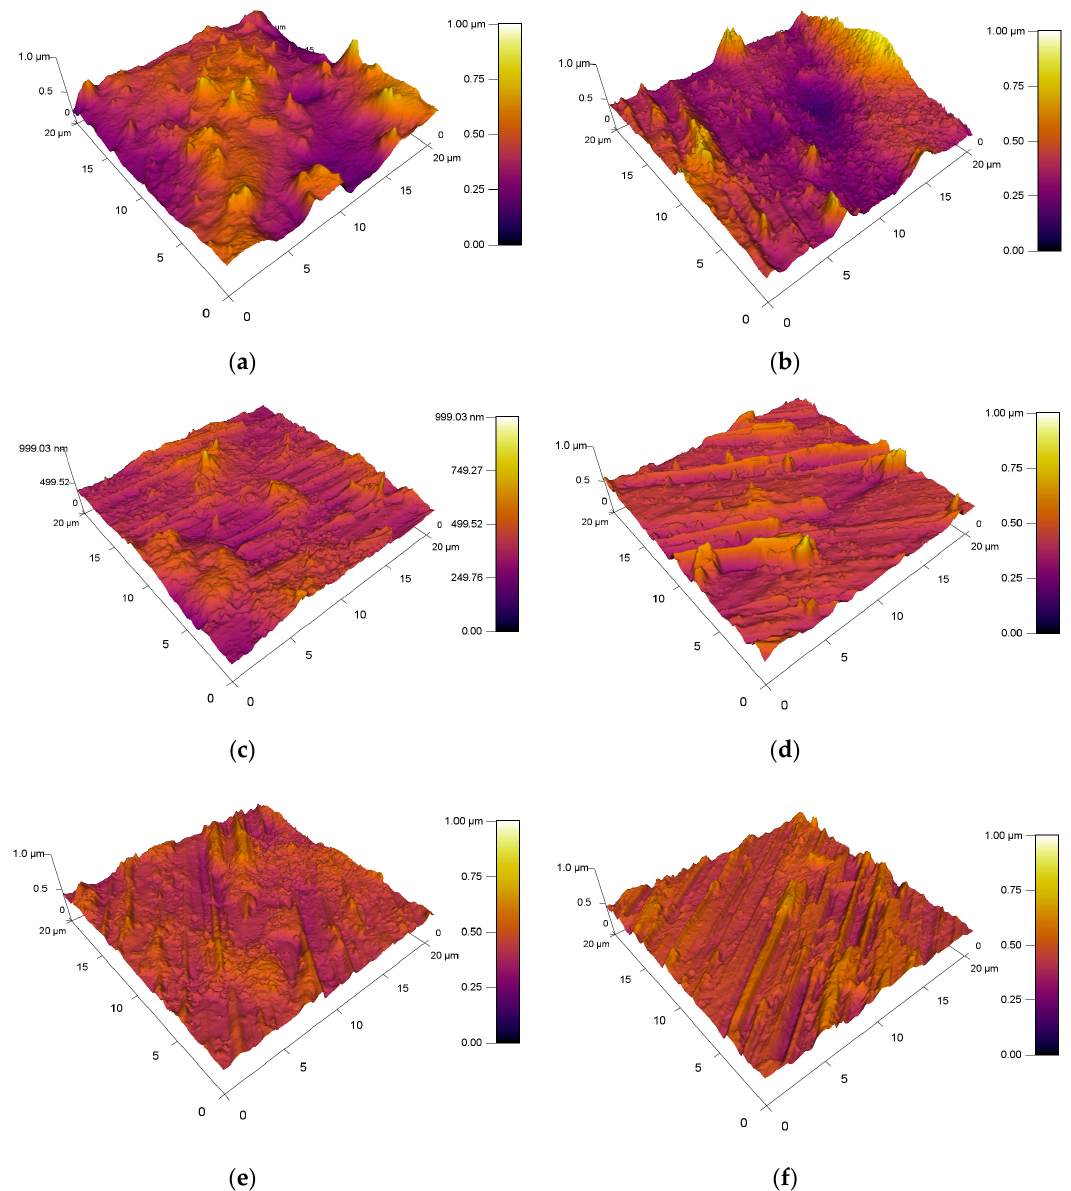
Figure 16. Evaluation of the roughness of tested ceramic balls at friction speed (m/s): ( a ) 0.2, ( b ) 0.4, ( c ) 0.6, ( d ) 0.8, ( e ) 1.0, ( f ) 1.2.